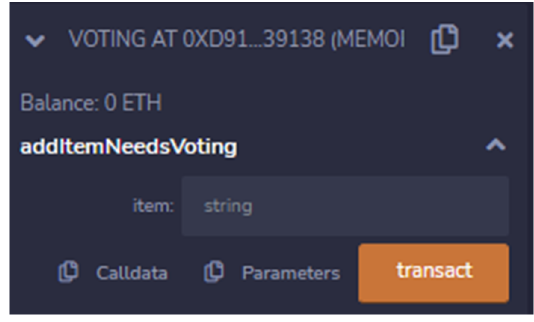
Figure 7. User input field GUI.